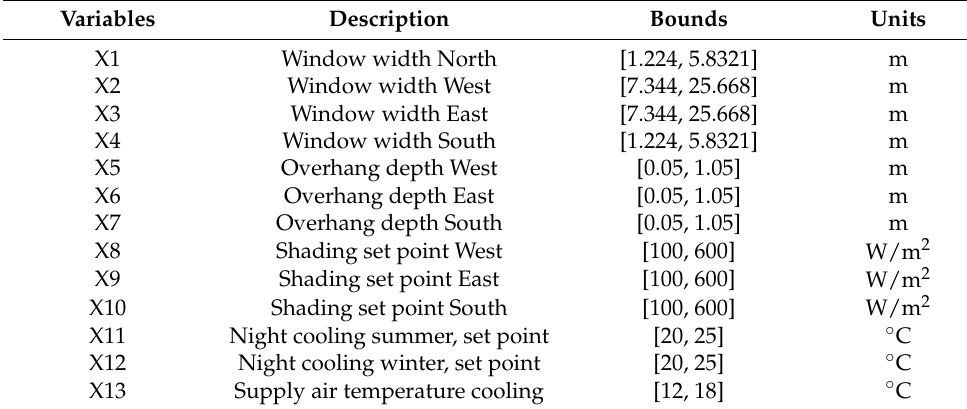
Table 2. The detailed office building’s decision